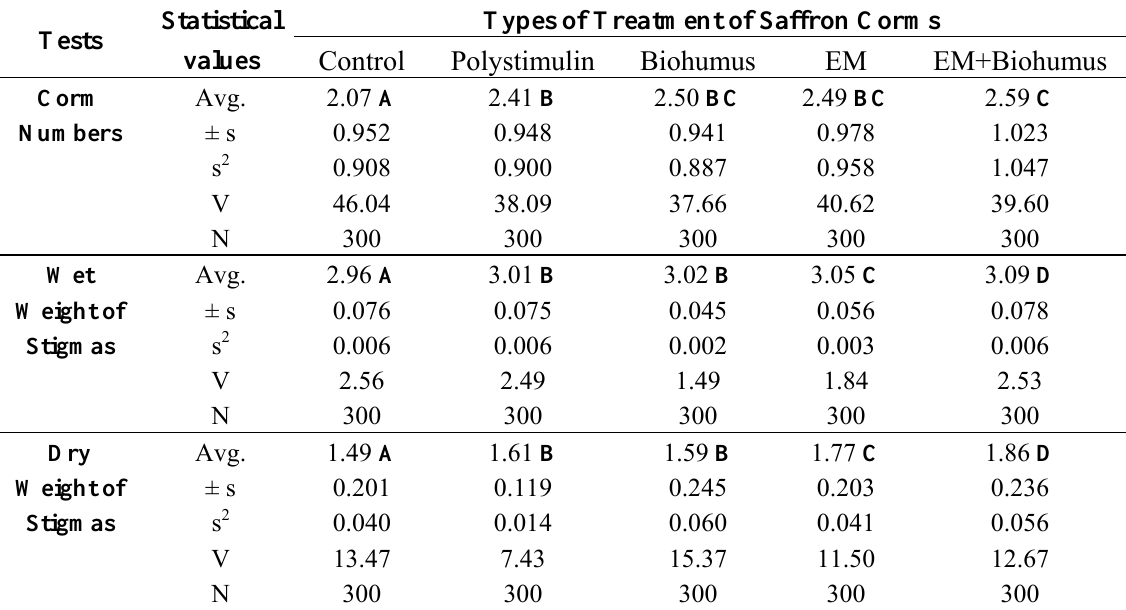
Table 1. Statistical information about corm numbers, dry and wet stigma